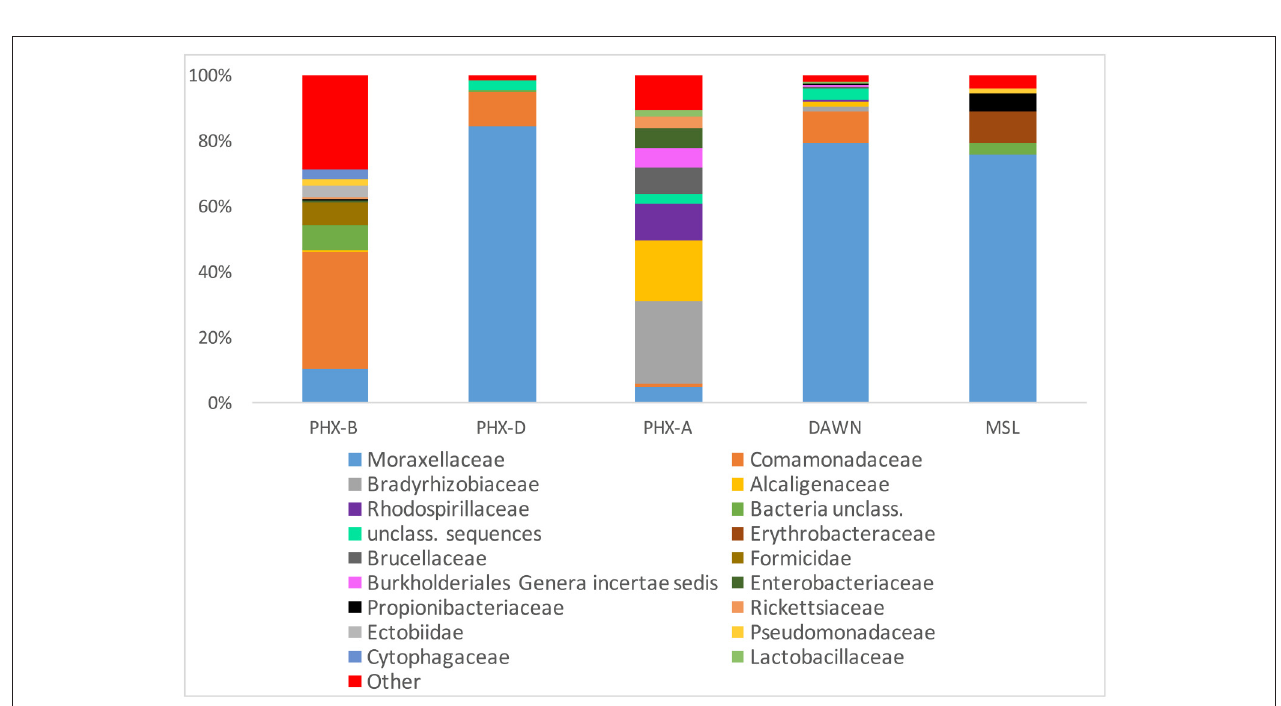
FIGURE 2 | Moraxellaceae dominate cleanroom during spacecraft assembly. Relative abundance of taxa at family level. Human, viral and archaeal impact was minimal. All taxa with a collective abundance of equal or less than 2% from all samples were combined in “Other”. See Presentation S1 in Supplementary Material for more details and lower taxonomic